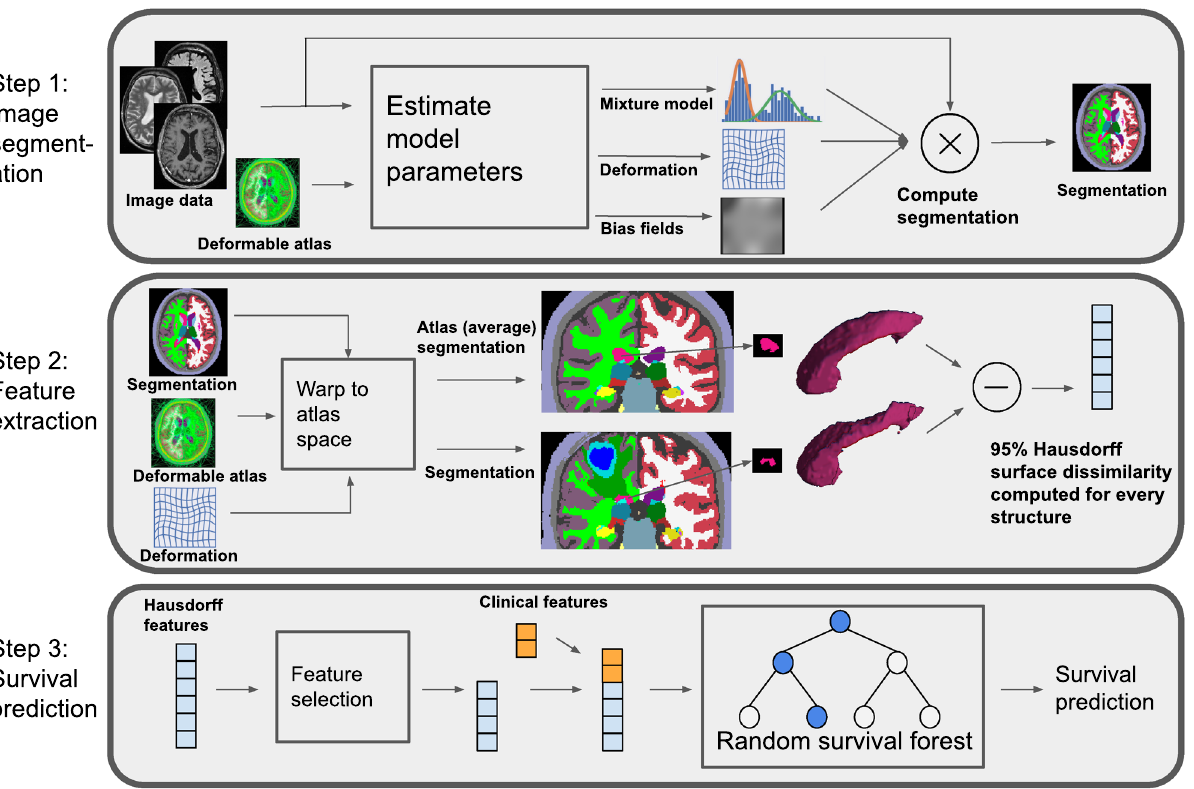
Figure 1. From MR images to survival prediction in three steps: segmentation, feature extraction, and survival prediction.